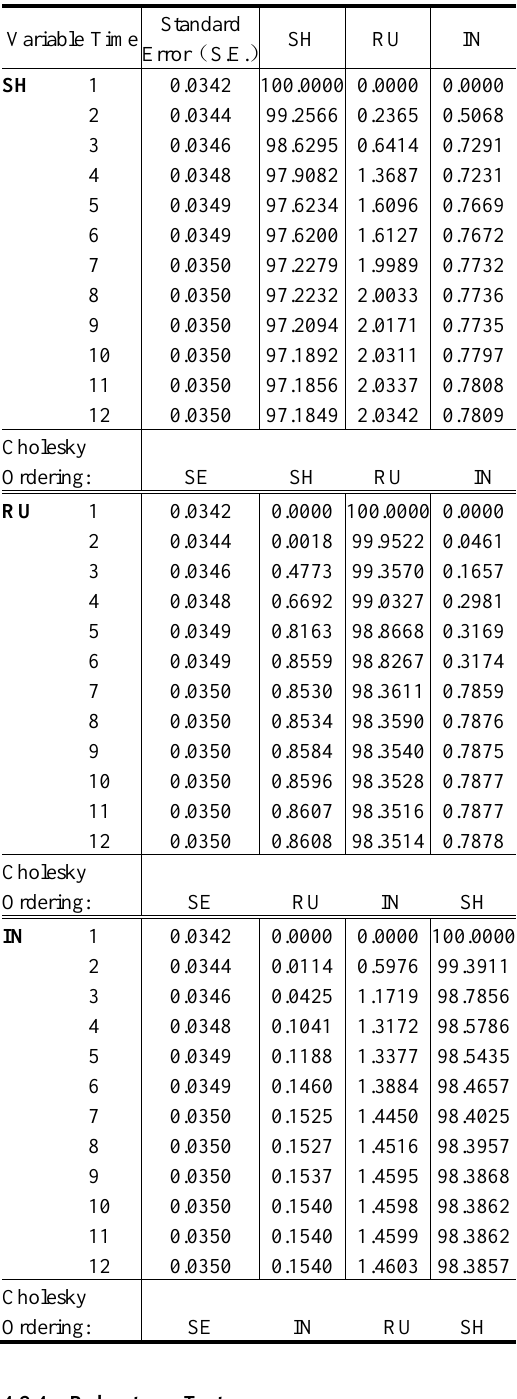
Variance Decomposition of Sample Series Standard Variable Time Error （ S.E. ）